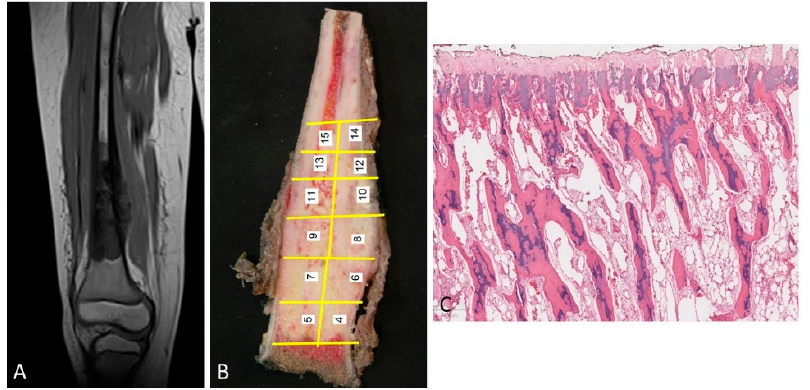
Figure 2. ( A ) MRI of an osteosarcoma that is separated from the cartilage growth. ( B ) The same osteosarcoma is studied macroscopically. The tumor is located away from the physis. In addition, the procedure of sampling the tumor is shown. ( C ) Normal physis without vascular angiogenesis and osteoblastic/osteoclastic activation when the tumor is far enough away from the physis (H&E, ×100).